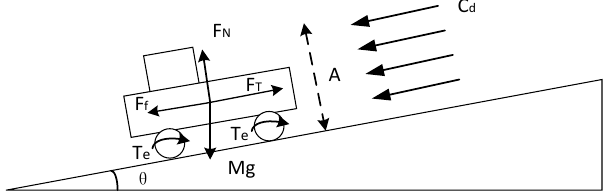
Figure 4. The vehicle dynamics analysis.